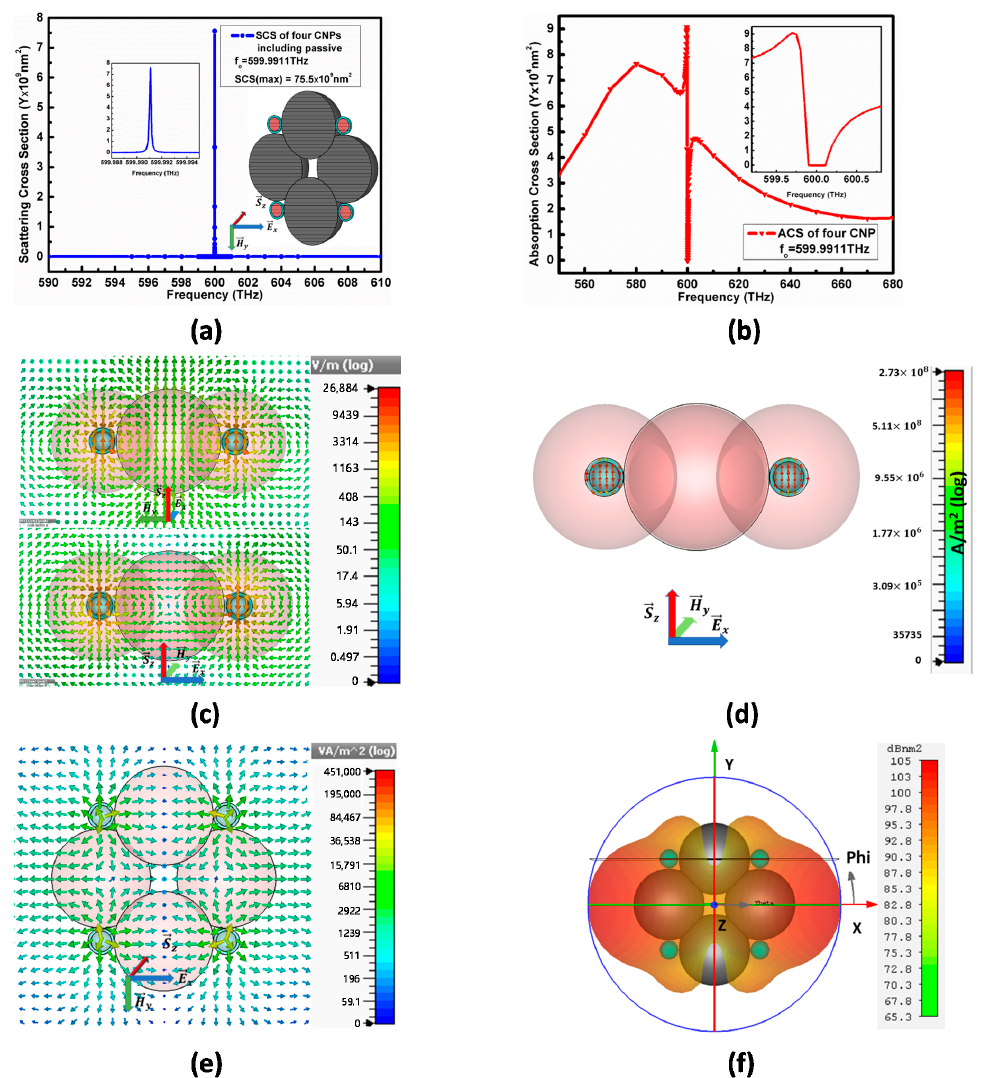
Figure 10. Excited model-II array: ( a ) SCS for four CNPS including passive spheres shows schematics diagram of model-II. ( b ) ACS for model-II. ( c ) E field in x-cut-plane and y-cut-plane at f = 599.9911 THz. ( d ) current distribution in y-cut-plane. ( e ) power flow in z-cut-plane, and ( f ) far-field at f = 599.9911 THz.